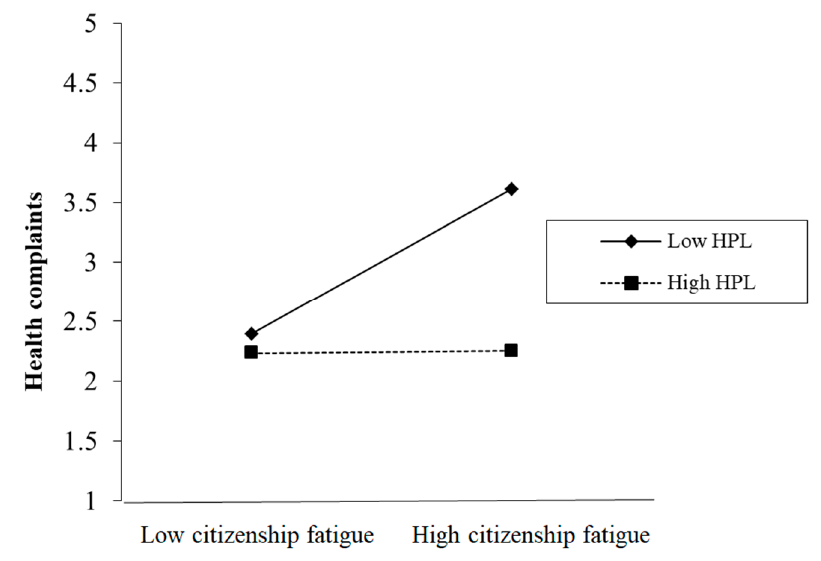
Figure 2. The moderating effect of HPL.